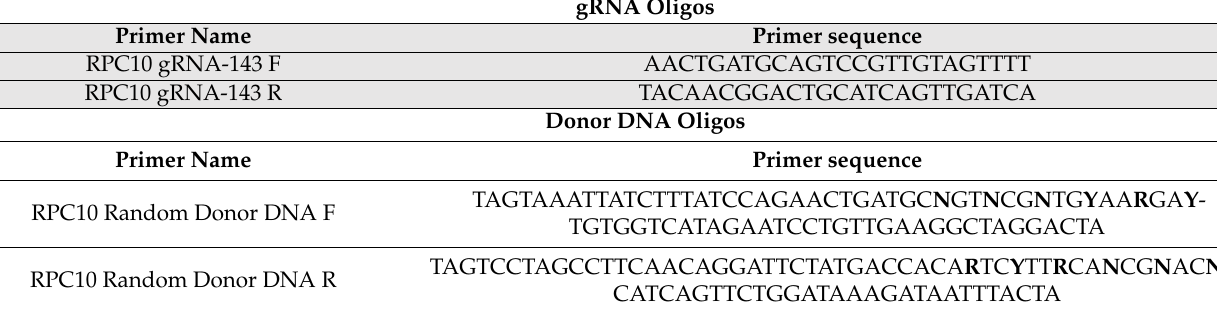
Table 3. Primers and